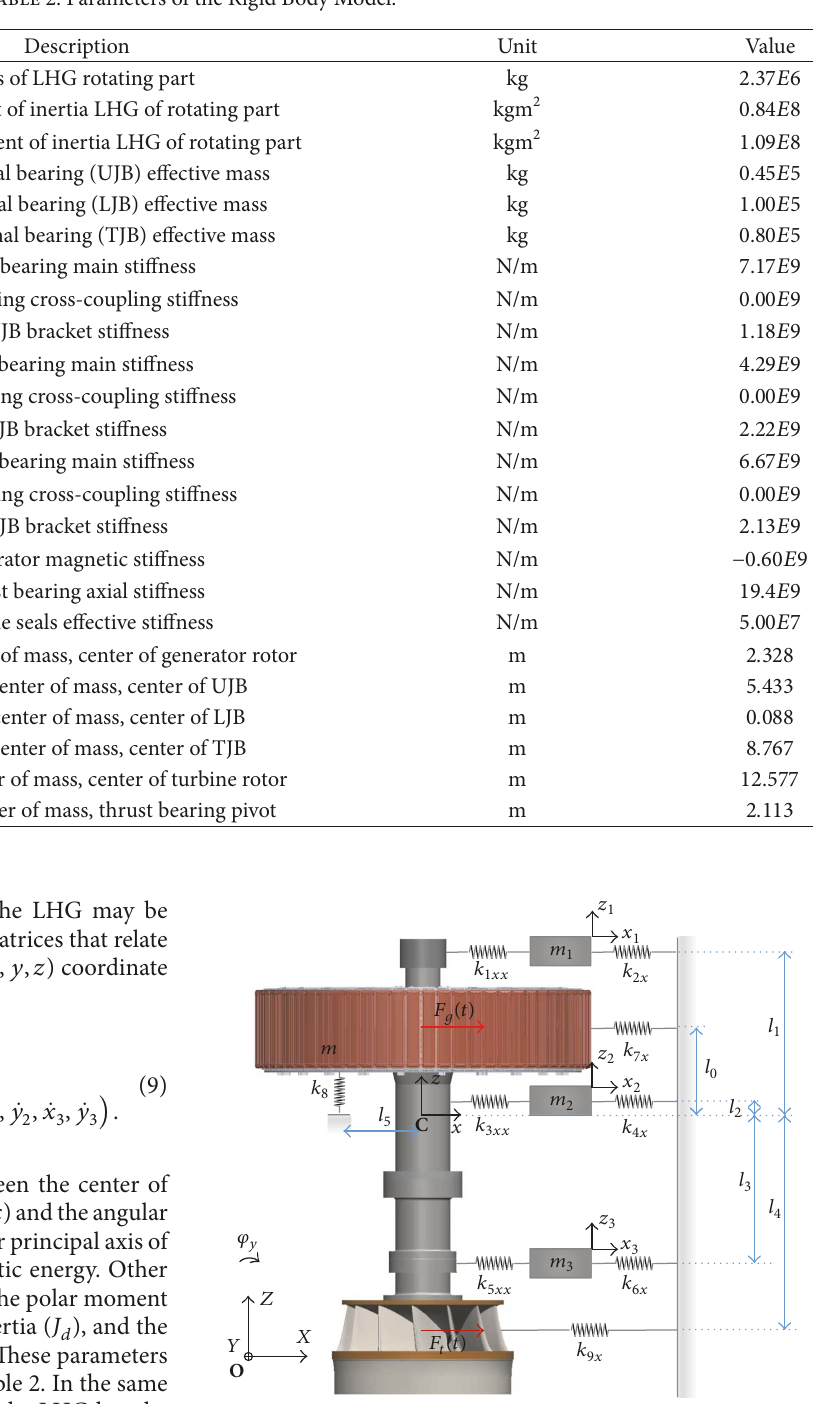
Figure10:Simplified10-DOFmodeltosimulateLHGdynamicbeh-